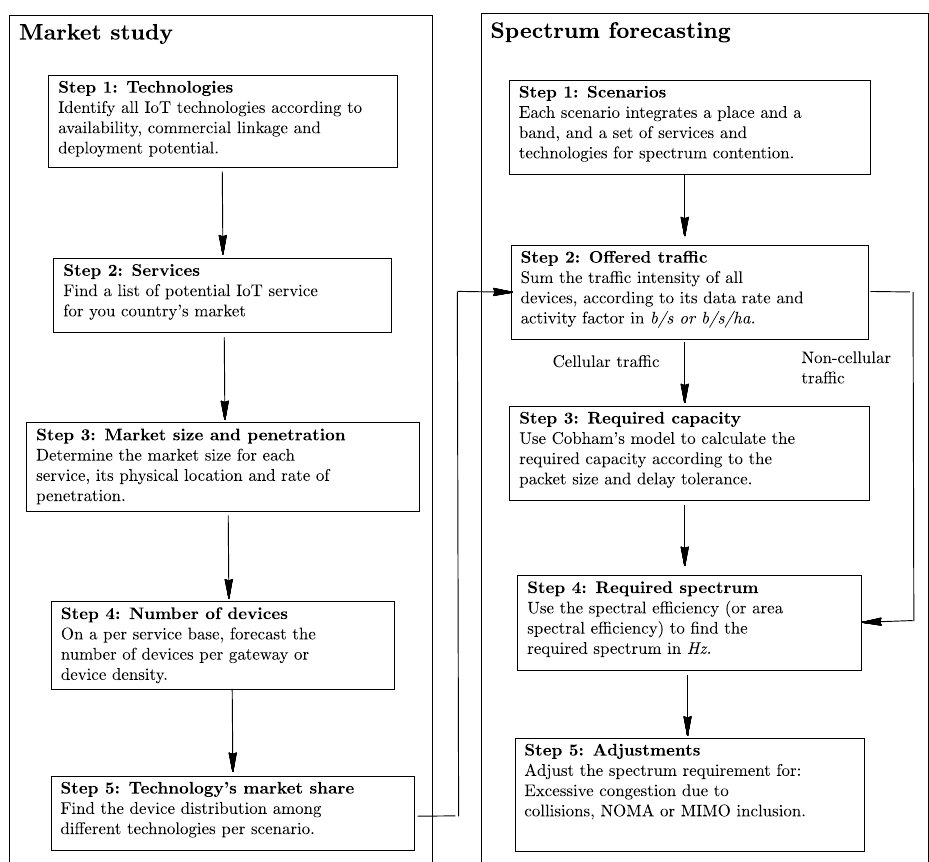
Figure 1. Flow diagram for IoT spectrum calculation